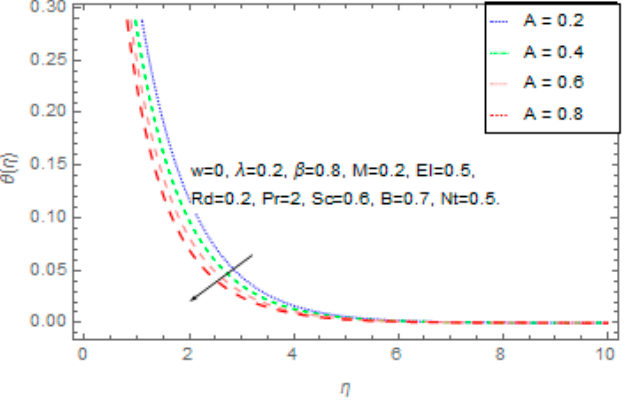
Figure 9. Influence of A on θ ( η ) Profile.